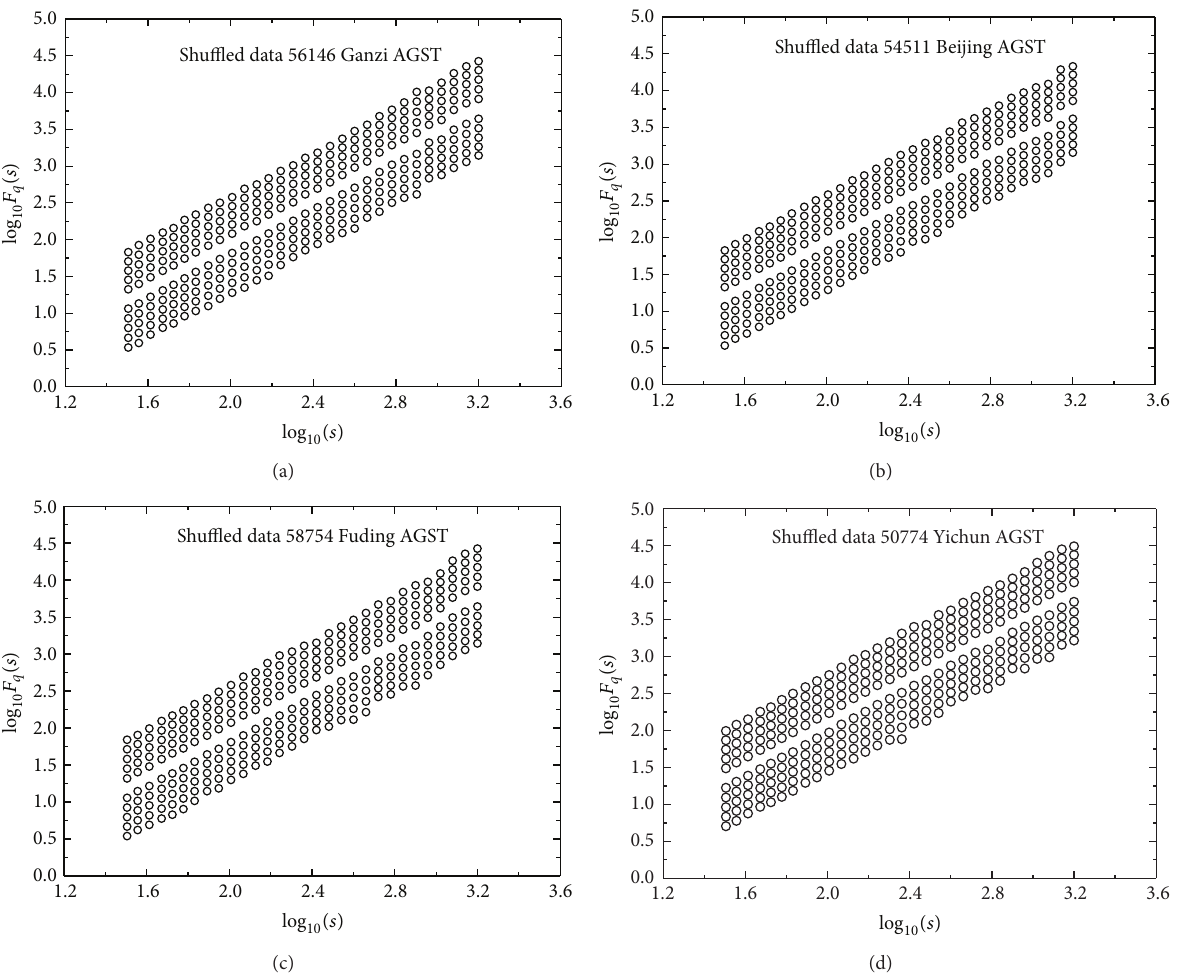
Figure 4: (a) Double log plots of the MF-DFA4 curves for the shuffled data of station Ganzi. From the top to the bottom, curves correspond to different 𝑞 (from 𝑞 = −5 to 𝑞 = 5 ). (b), (c), and (d) The analog to (a) but for Beijing, Fuding, and Yichun.